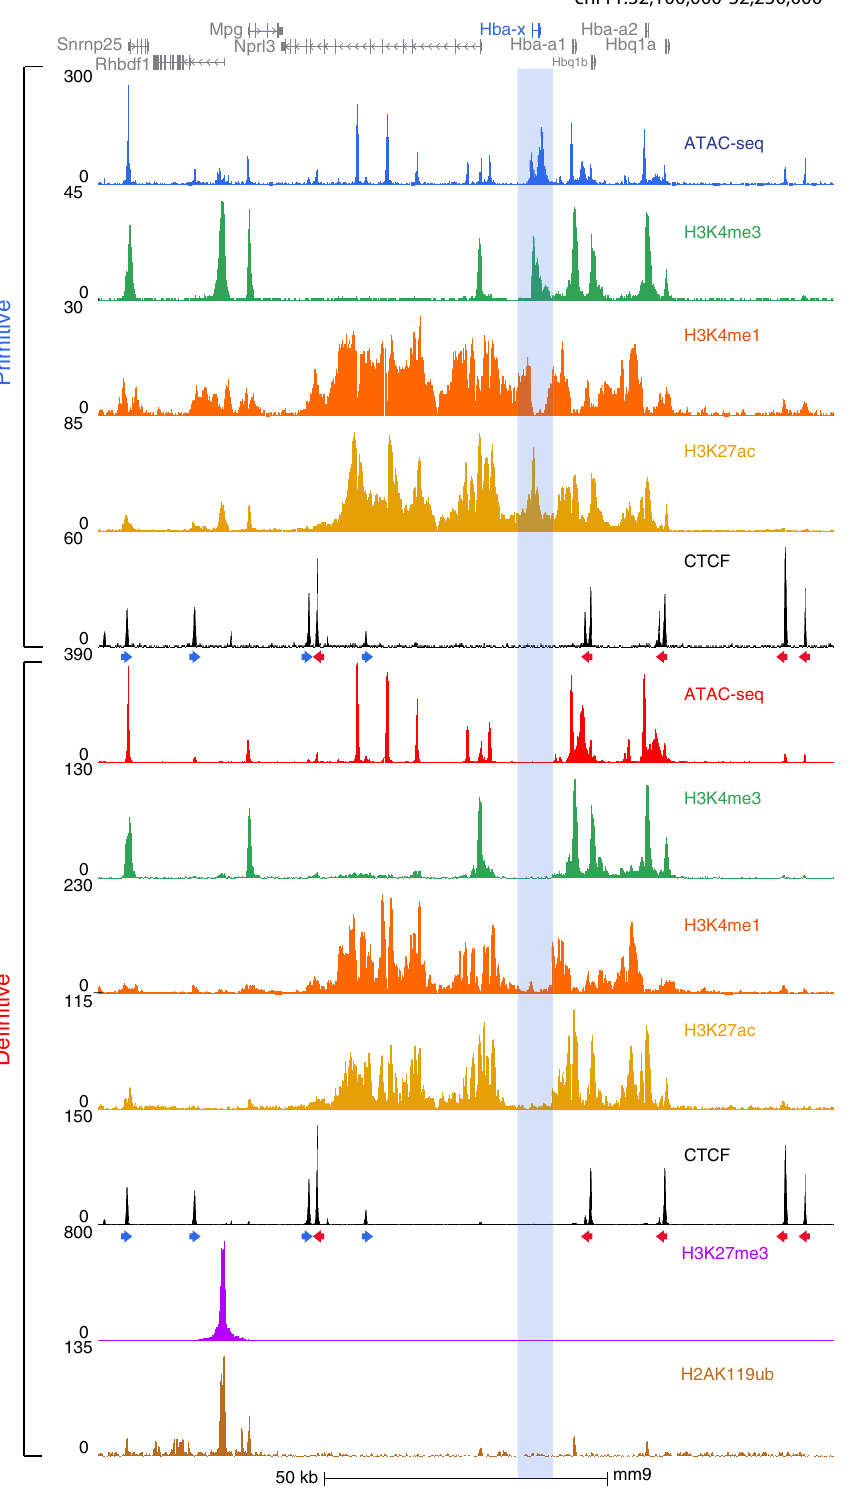
Fig. 3 The ζ -globin gene lies within a small, discrete region of hypoacetylated chromatin in de fi nitive erythroid cells. ChIP-seq tracks for H3K4me3, H3K4me1, H3K27ac, and CTCF in primitive erythroid cells at the α -globin locus. An ATAC-seq track is shown for orientation. The Hba-x gene is highlighted in blue throughout. The orientation of CTCF sites is shown below the CTCF tracks. The same histone marks for de fi nitive erythroid cells are shown, along with H3K27me3 and H2AK119ub which are associated with polycomb